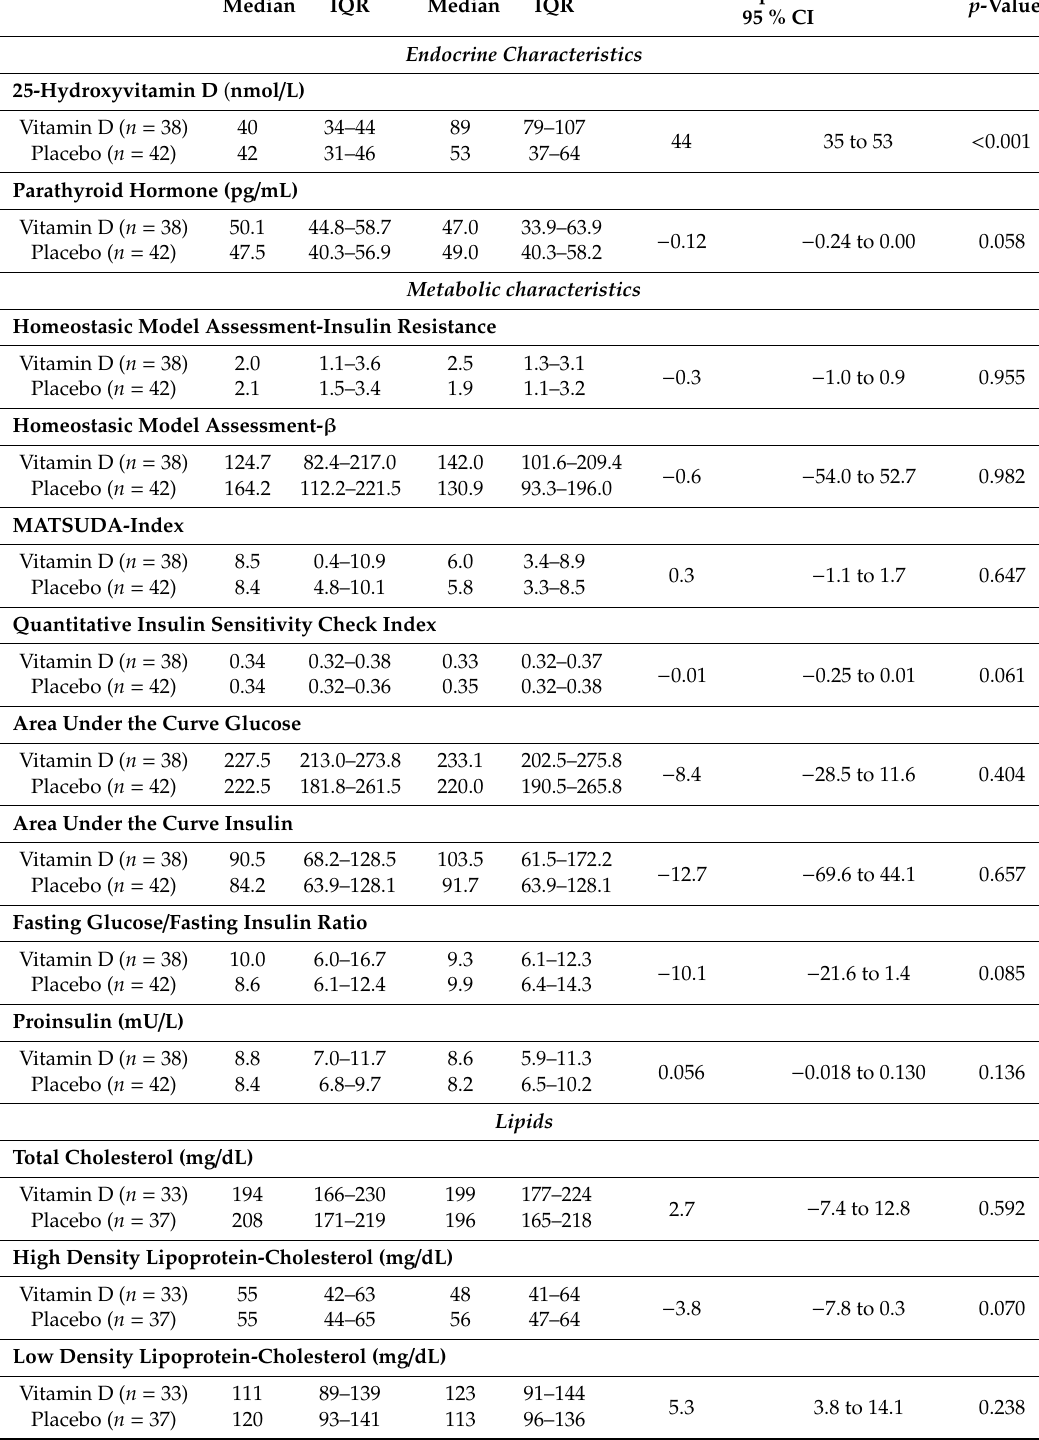
Table 3. Continuous outcome variables at baseline and follow-up at study end (12 weeks) in study participants with 25 hydroxyvitamin D < 50 nmol / L at baseline and available values at both study visits. Data are shown as medians and interquartile range. Treatment e ff ects with 95% confidence interval and p -values were calculated by ANCOVA for group di ff erences at follow-up with adjustment for baseline